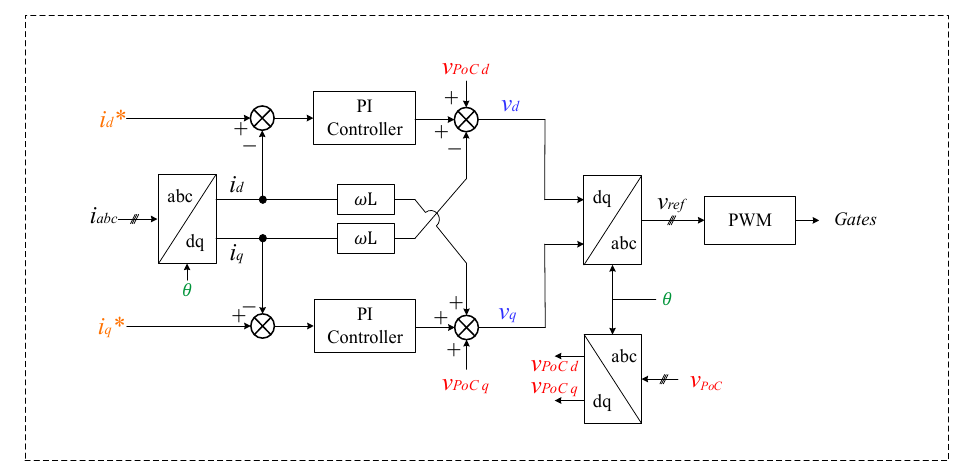
Figure 12. The dq-frame current control loop of a grid-connected power converter. The inner control circuit receives dq-current signals from the outer control loop and supplies the PWM circuit with the appropriate reference signals. A PI controller processes the difference between the reference and measured dq-current components, and the ref- erence signals ( v ref ) are derived following the inverse Park’s transformation. To enhance the transients of the conversion system, compensations of the feedforward voltage and cross-coupling current due to the dq transformation are typically used [33,34]. The